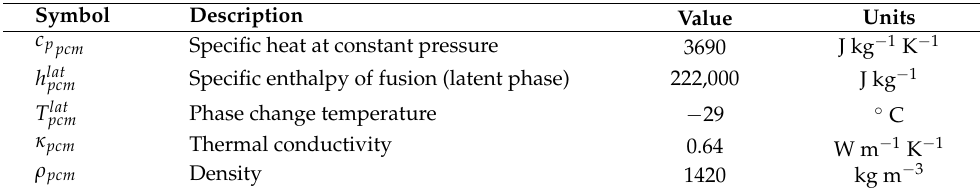
Table 3. Phase change material